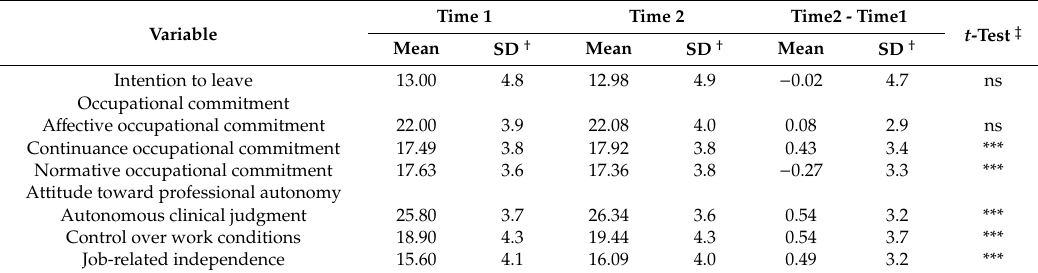
Table 2. Descriptive statistics of nurse variables at Time 1, Time 2, and Time 2 − Time 1 ( n =